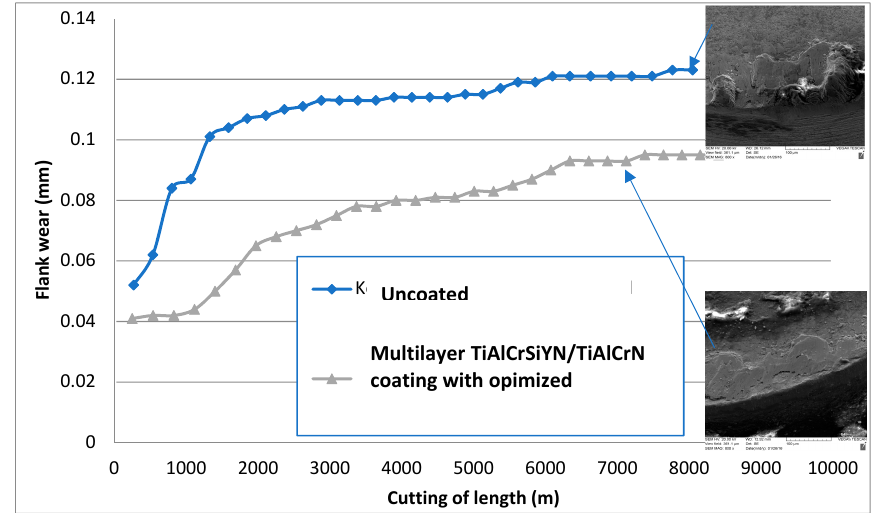
Figure 6. Wear resistance data (flank wear vs. length of cut) of SDSS machining for uncoated and PVD coated cutting tools with varying machining conditions. Reproduced from [31].